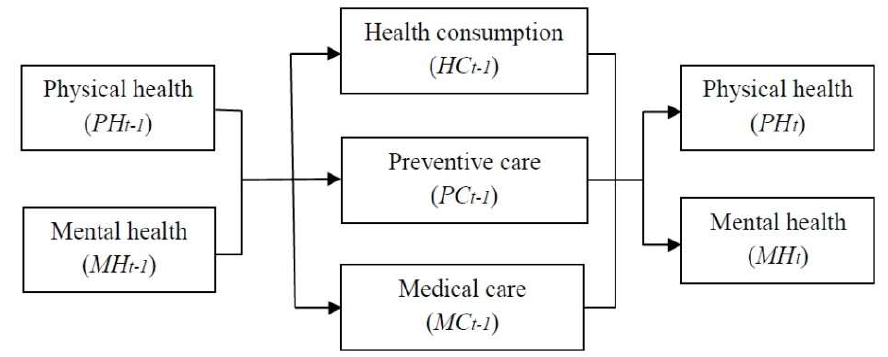
Figure 2. The relationship between previous and current health status